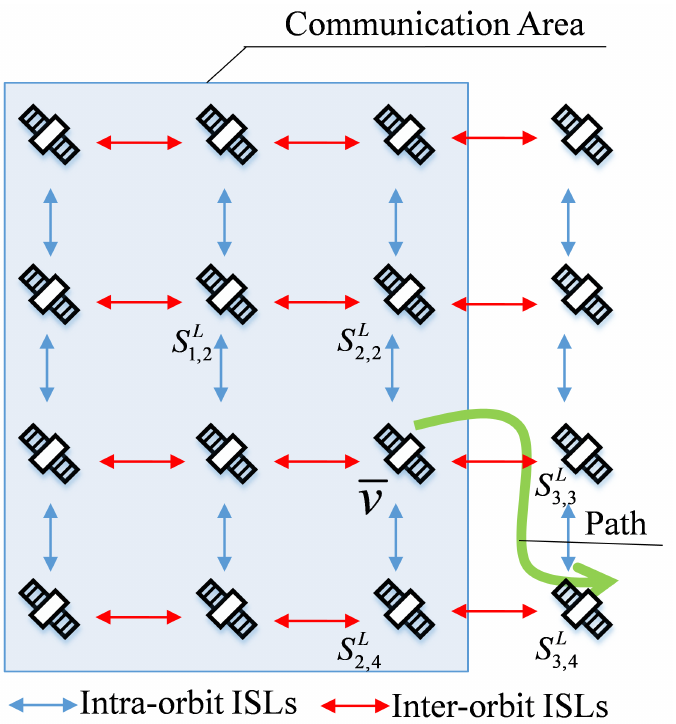
Figure 7. The relationship between packet transmission path and communication domain Equation